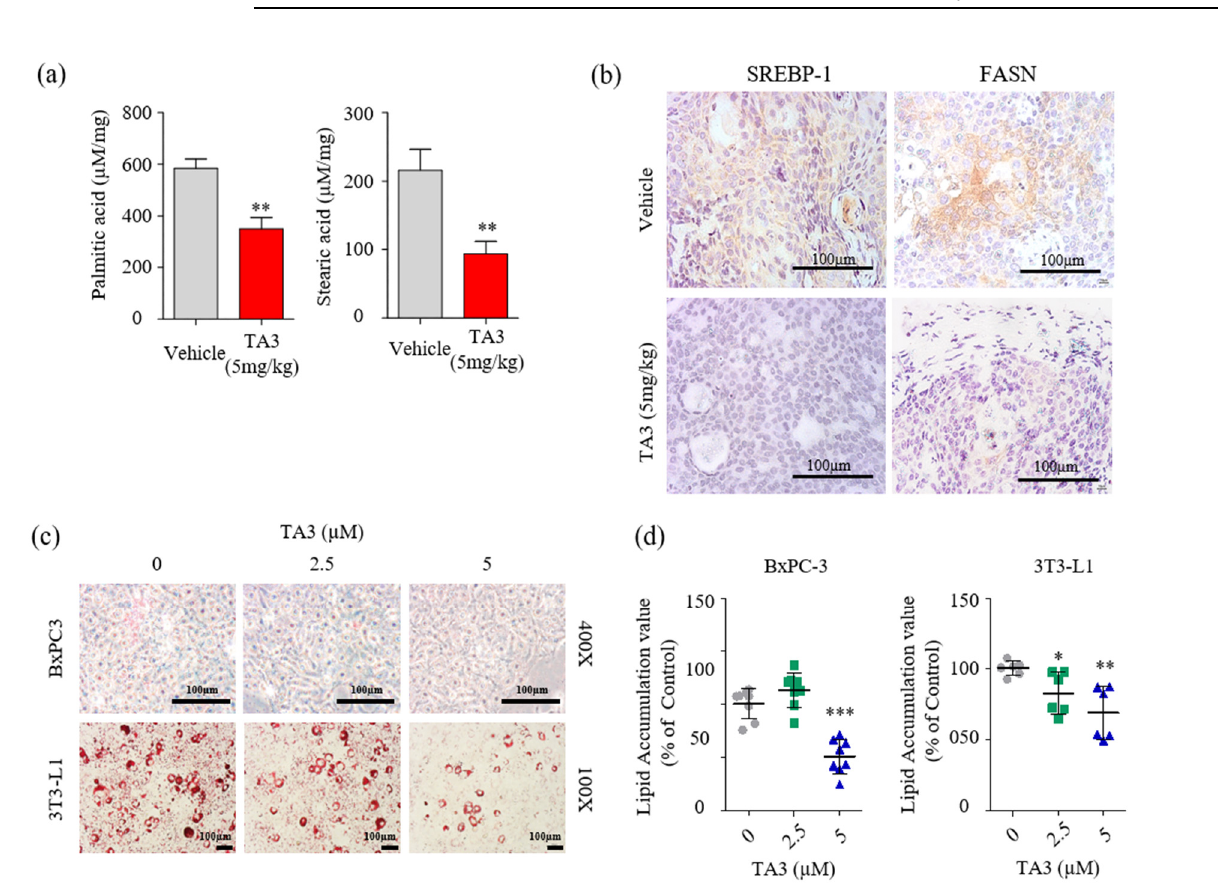
Figure 6. TA3 inhibited SREBP-1 and FASN expressions, which were involved in the lipogenesis pathway, and lowered fatty acid levels in pancreatic tumor tissues. ( a ) Comparison of concentra- tions of palmitic acid and stearic acid in the vehicle and TA3 groups’ tumor tissues using